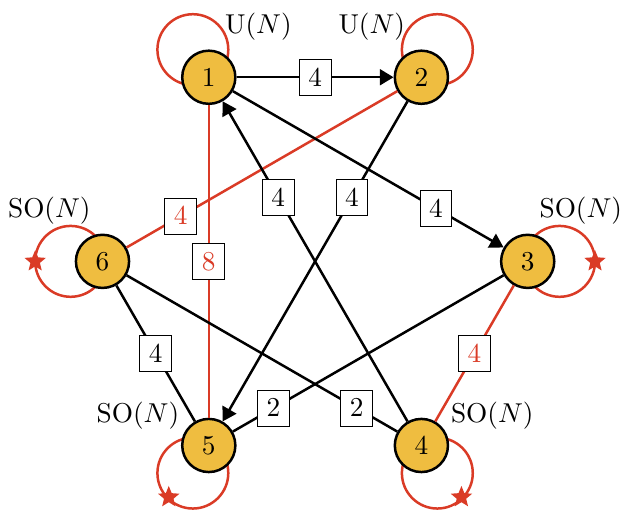
Figure 26 . Quiver diagram for the Spin(7) orientifold of phase E of Q 1 , 1 , 1 / Z 2 using the involution in eqs. (C.2), (C.3) and (C.4), together with our choice of γ